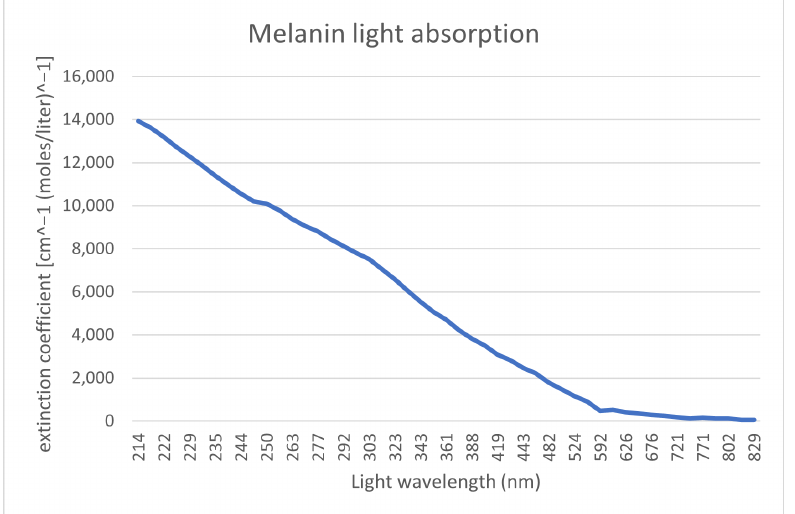
Figure 3. Melanin light absorption [7].